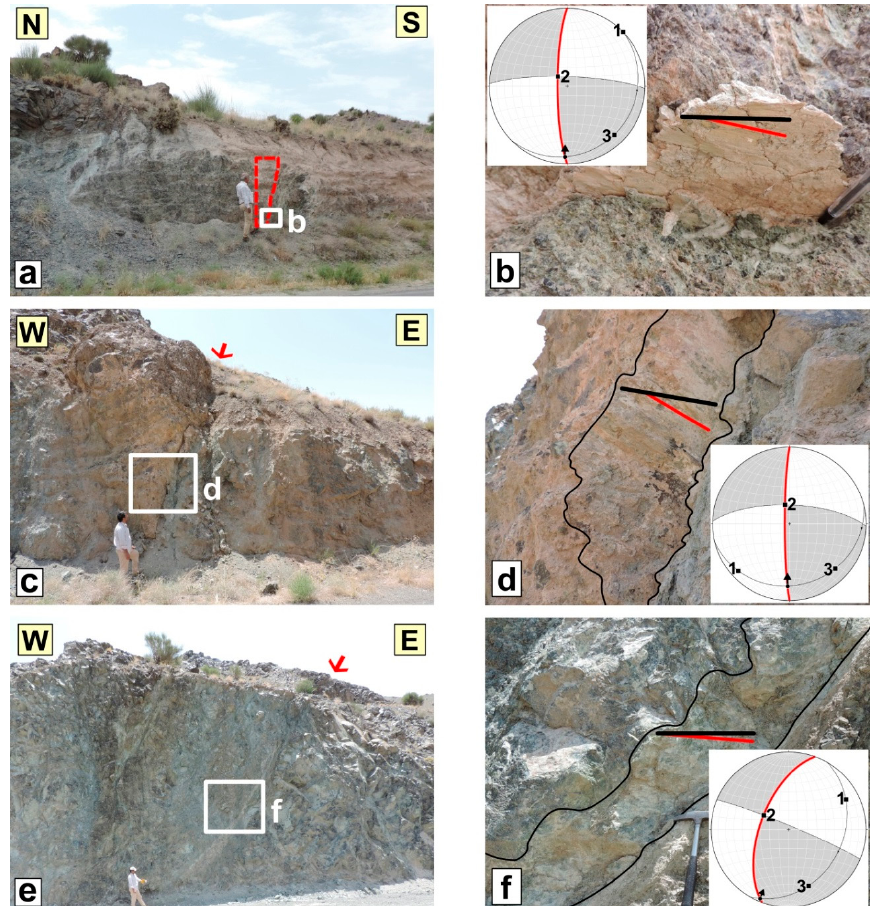
Figure 3. The Fanud fault with striations on its three segments (see the locations on Figure 1d). ( a ) Fault outcrops in the Cretaceous flysch with an attitude of N00°S, 80°W. ( b ) Close-up view of the slicken lines on the fault plane (182°/10°). ( c ) Fault trace in the Pleistocene terraces and gravel fans with attitude of N00°S, 85°W. ( d ) Close-up view (to the west) of the slicken lines on the fault plane (182°/20°). ( e ) Fault plane in the upper Cretaceous calc-schists with attitude of N20°E, 60°NW. ( f ) Close-up view of the slicken lines (202°/04°).